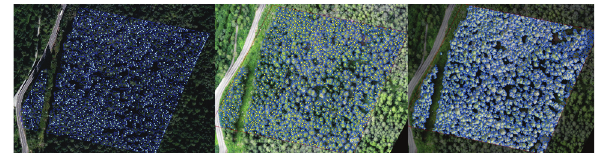
Figure 13: EO, UAV, UAV-DTM Tree delineation analysis